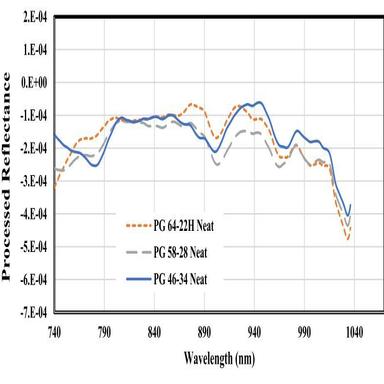
Comparison of different neat binders.